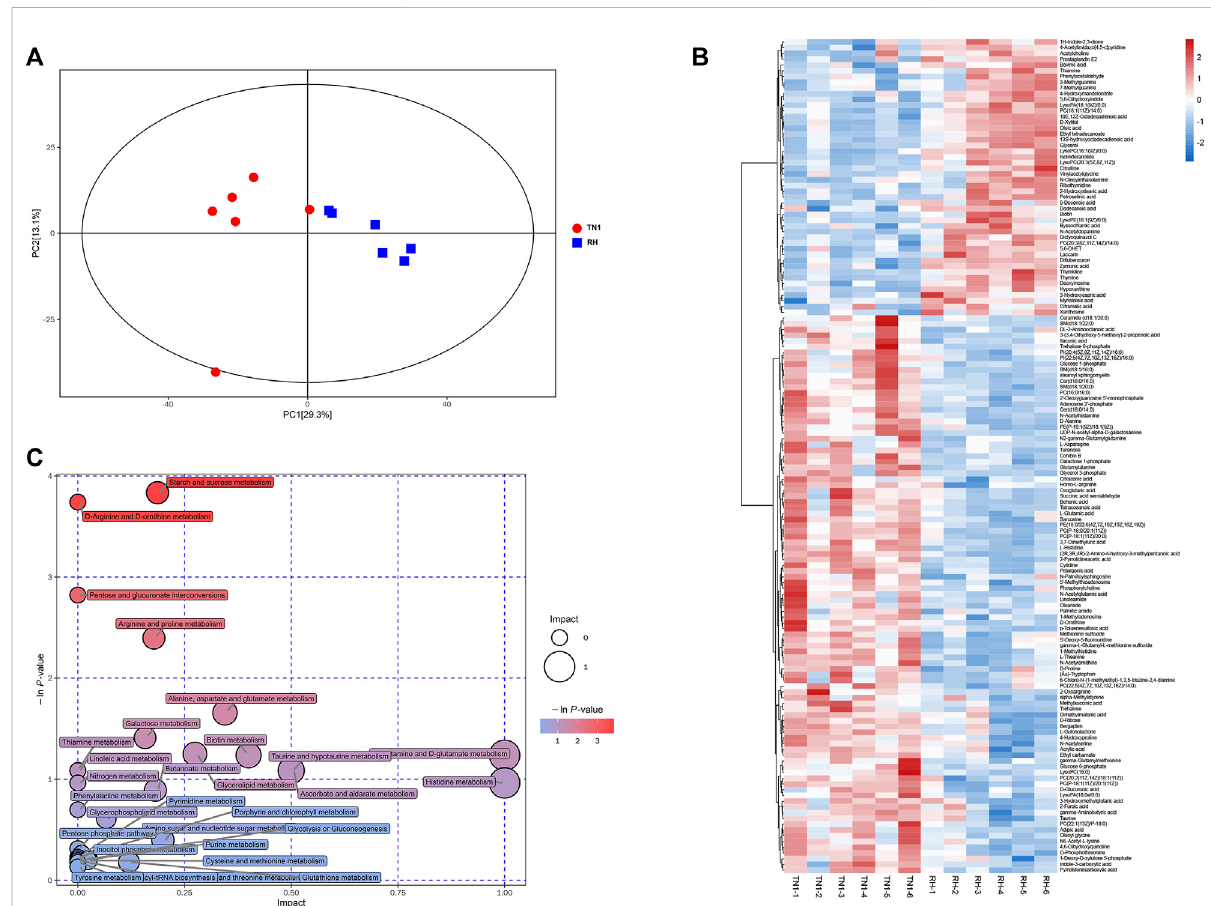
FIGURE 4 Impact of feeding different rice varieties on the metabolic pro fi le of BPH. (A) Principal component analysis (PCA) plots of the metabolite composition of samples from BPH reared on RH and TN1 varieties. Each symbol represents a sample, different symbol shapes denote different groups.Thecircularlineindicatesthe95%con fi denceinterval(Hotelling ’ sT-squaredellipse). (B) Hierarchicalclusterof12BPHsamplesfromthetwo different rice plants ( n = 6) and heatmap displaying the levels of the differential metabolites in each sample. (C) KEGG pathway annotation of differential metabolites between BPH reared on RH and TN1 varieties. The point size represents the signi fi cant compound number in the corresponding pathway. 12 BPH samples from the two different rice plants ( n = 6). The heatmap displays the levels of the differential metabolites in each